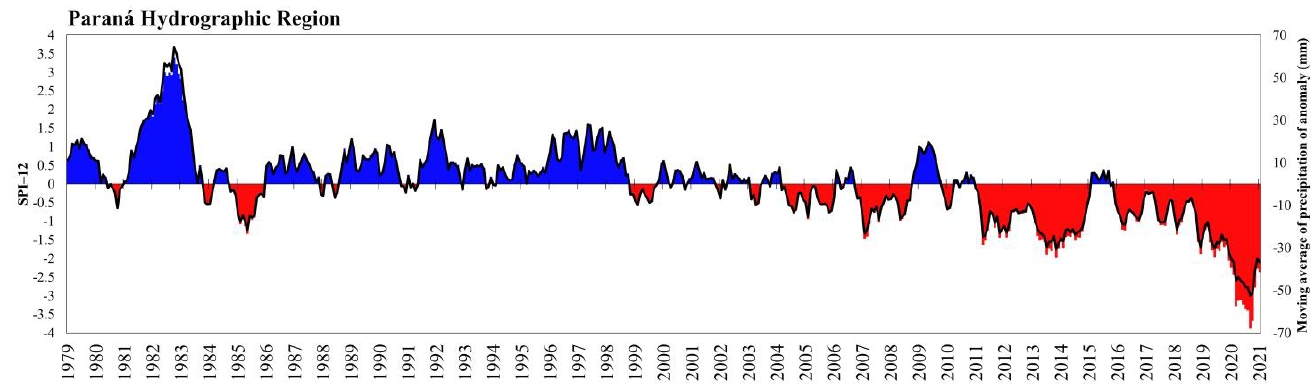
Figure 4. SPI-12 time series, and in the black line, the 12-month moving average of anomalies of precipitation (mm) to PHR.